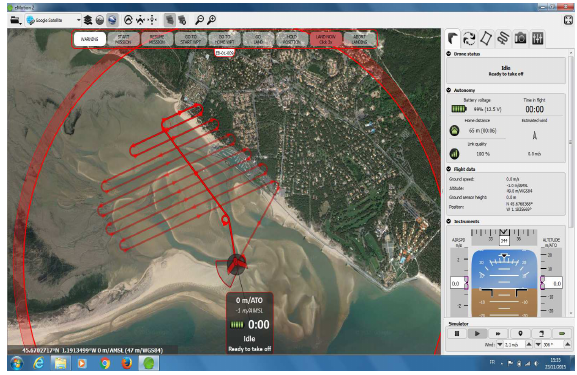
Figure 4. Flight plan set up on the eMotion® software Two flights were set up which characteristics are summarized on the Table 1.